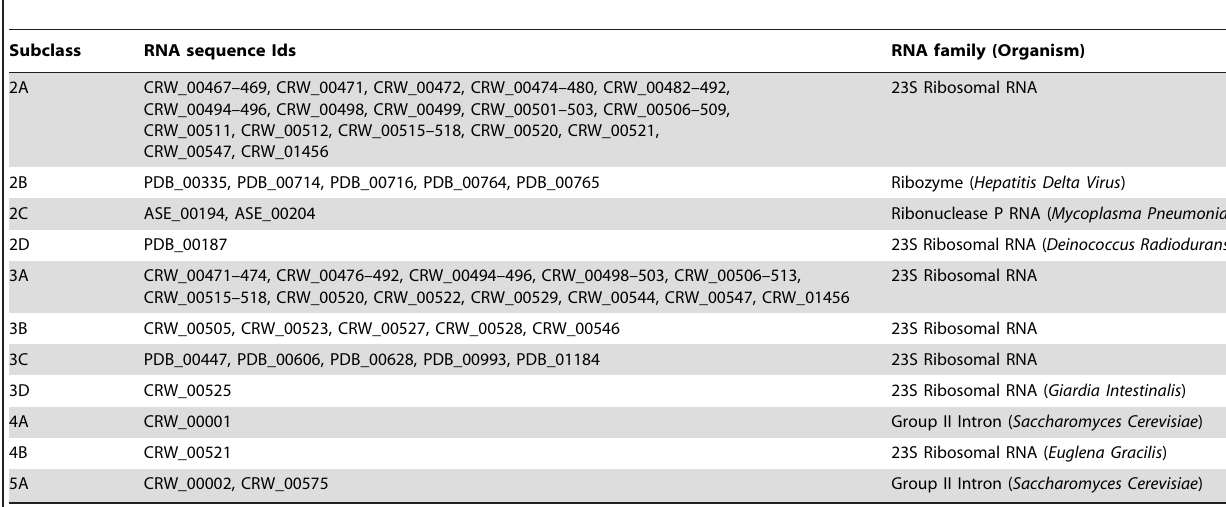
Table 4. RNA sequence Ids (in RNA STRAND) and RNA family for subclasses with genus $ 2.